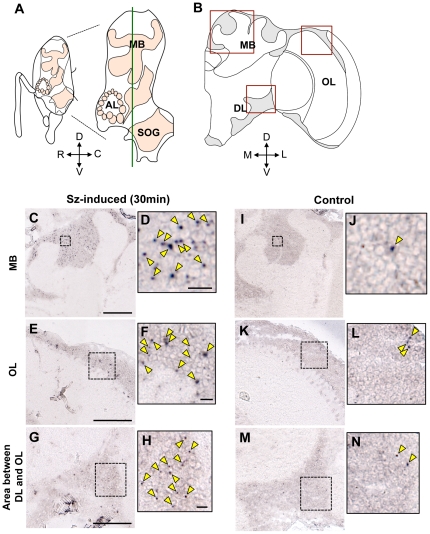
Seizure-induced neural activity in the brains of the Japanese honeybee workers.(A) Schematic diagram of the lateral view of a bee brain. Areas colored in light orange indicate neuropil regions. D, dorsal; V, ventral; R, rostral; C, caudal. MB, mushroom bodies; AL, antennal lobes; and SOG, subesophageal ganglion. The green line indicates the position of sections analyzed in this experiment. (B) A schematic diagram of a middle right brain hemisphere of the Japanese worker honeybee. Areas colored in light grey indicate brain areas where the somata of neurons are located. Red squares correspond to brain areas whose in situ hybridization results are presented below. M, medial; L, lateral. OL, optic lobe; DL, dorsal lobe. (C–N) Expression analysis of Acks by in situ hybridization using coronal brain sections of seizure-induced (Sz-induced) (C–H) or control Japanese honeybee workers (I–N). The upper panels (C and I), middle panels (E and K), and lower panels (G and M) correspond to MB, OL, and area between the DL and OL, which are boxed in (B). Bars indicate 100 µm. (D, F, H, J, L, and N) Magnified views of the regions delineated by dotted lines in panels (C), (E), (G), (I), (K), and (M), respectively. Yellow arrowheads indicate Acks signals. Bars indicate 10 µm.